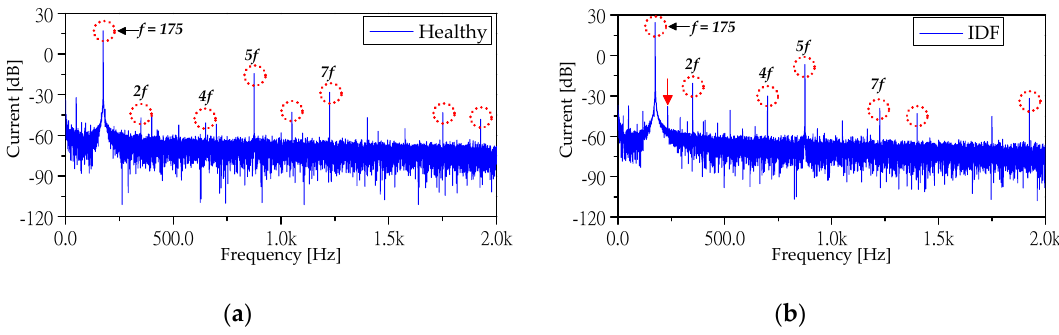
Figure 4. Frequency spectrum of the stator current for healthy and faulty machine at rated load and speed, ( a ) healthy machine; ( b ) IDF.